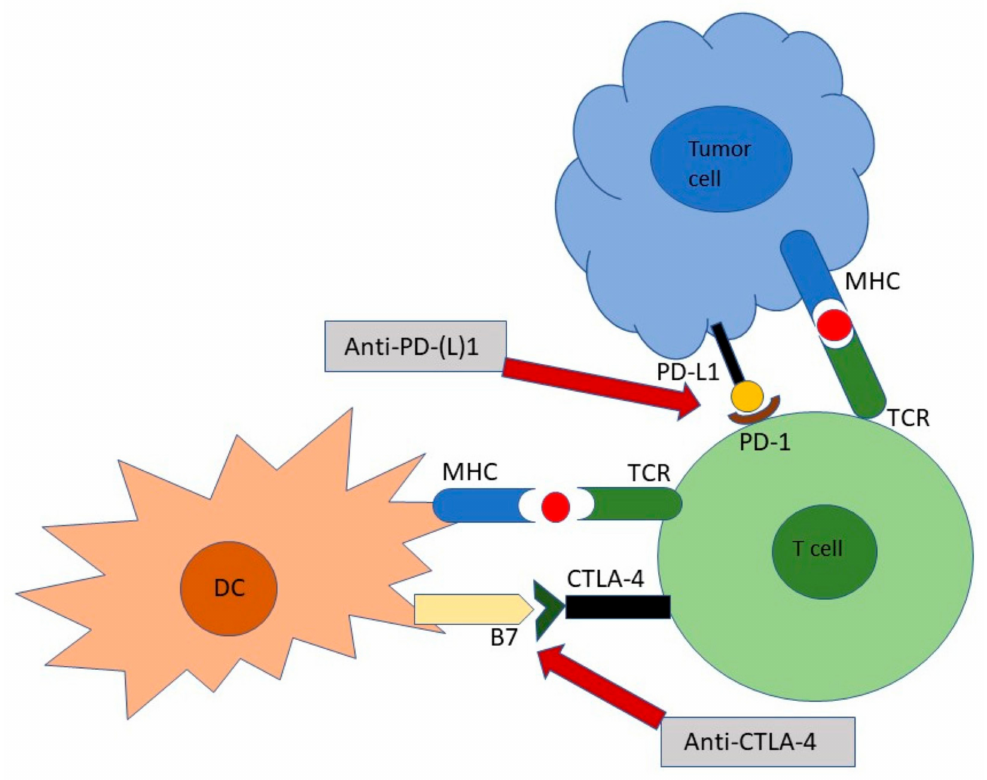
Figure 1. Mechanism of immune checkpoint blockade through CTLA-4 and PD-L1 / PD-1